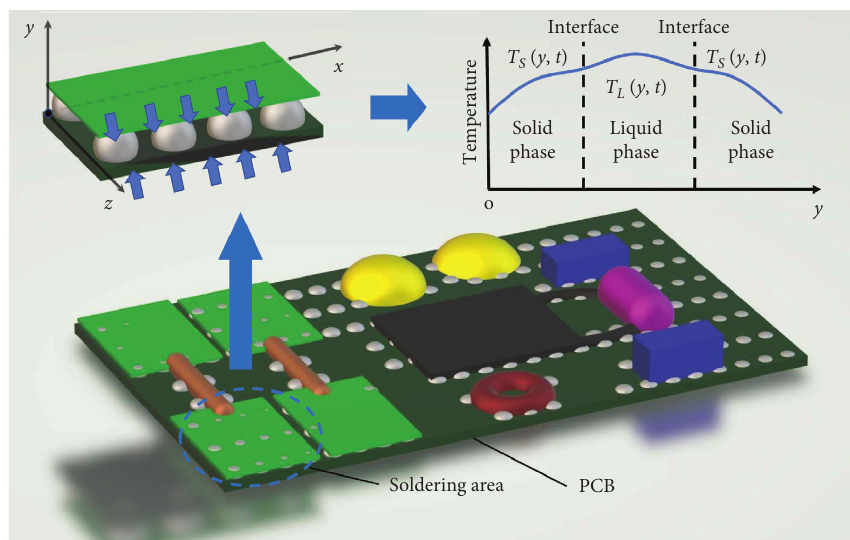
Figure 4: Phase transformations in the cooling process.